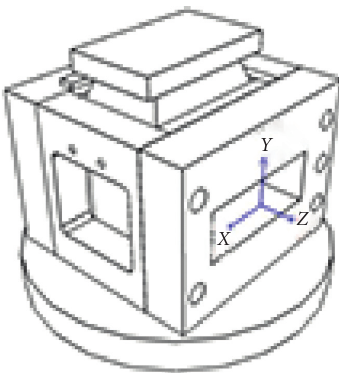
Figure 9: VIC-3D system direction